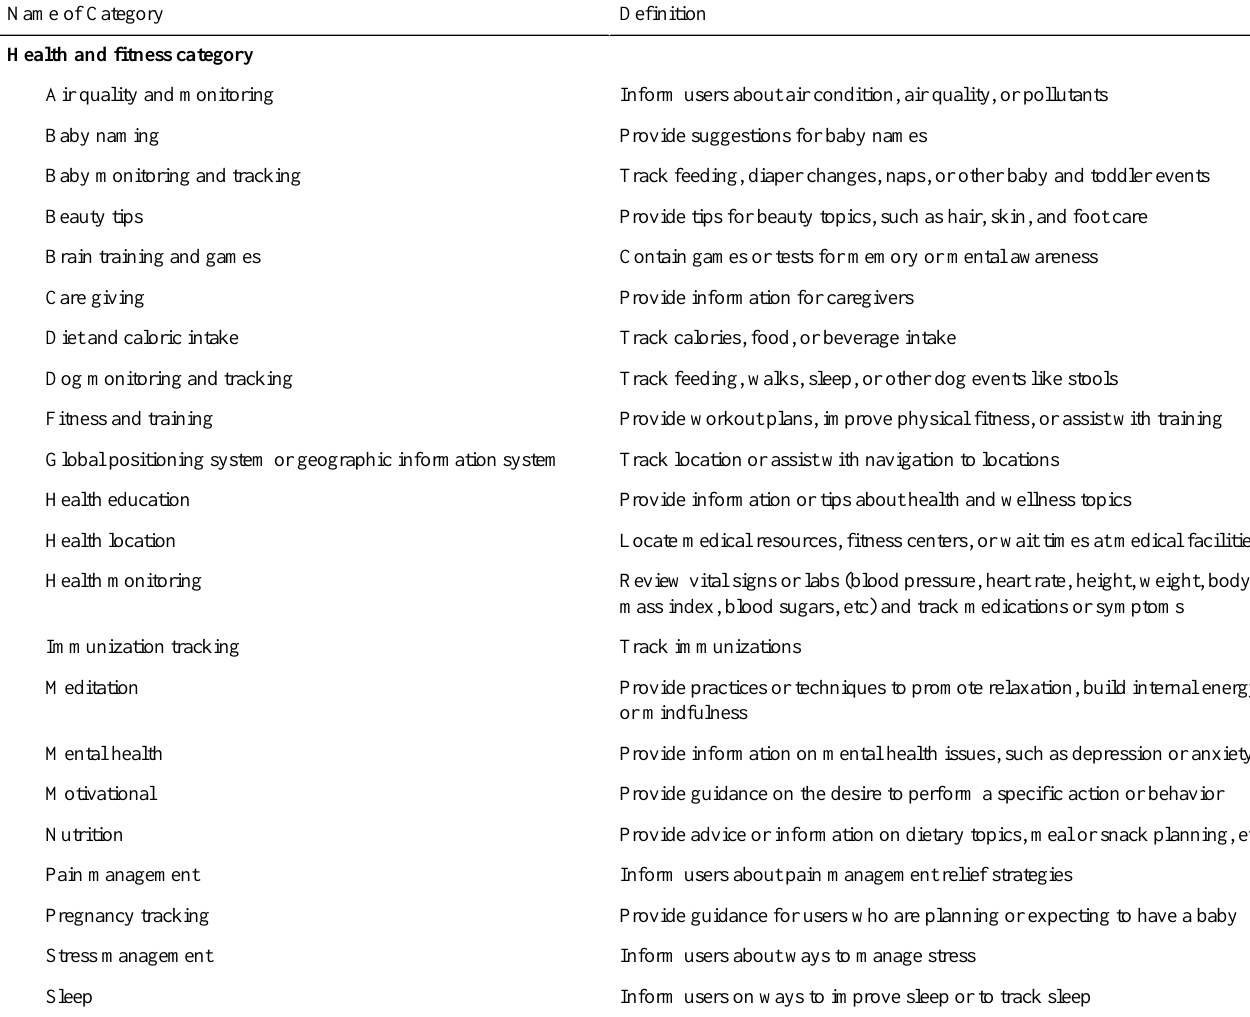
Table 1. Definitions of health and fitness, target audience, and intended age group categories. DefinitionName of